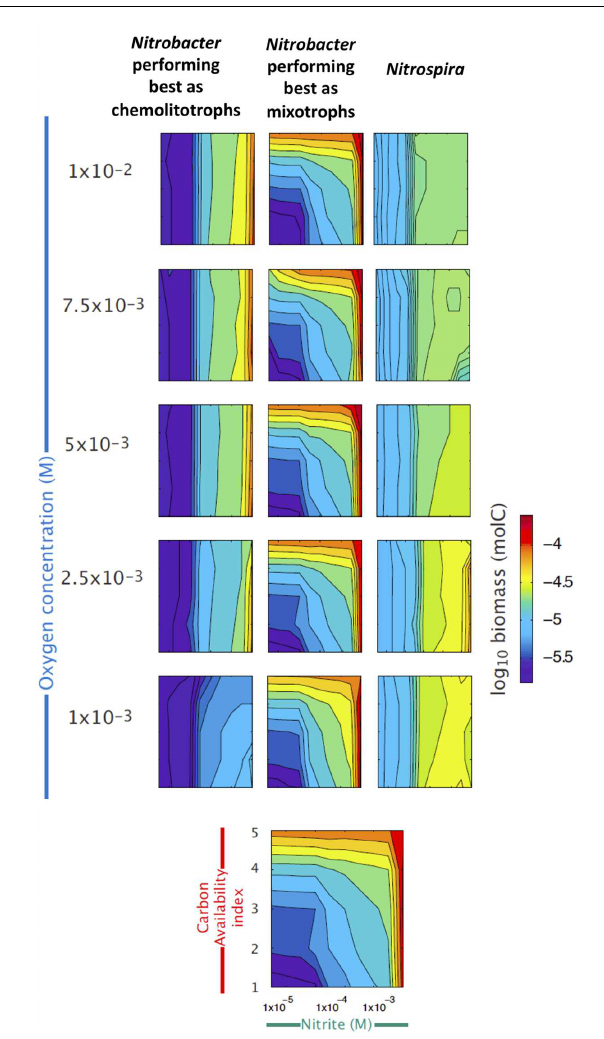
FIGURE 3 | Reconstructed niches of the three NOB groups across environmental gradients. Simulated changes in the abundances of the three functional types of nitrite oxidizers (see Supplementary Table S1), expressed as log 10 of biomass, are presented across gradients of nitrite ( X axis), organic carbon (red Y axis), and oxygen availabilities (blue Y axis). The last panel at the bottom provides the scales used in all panels.